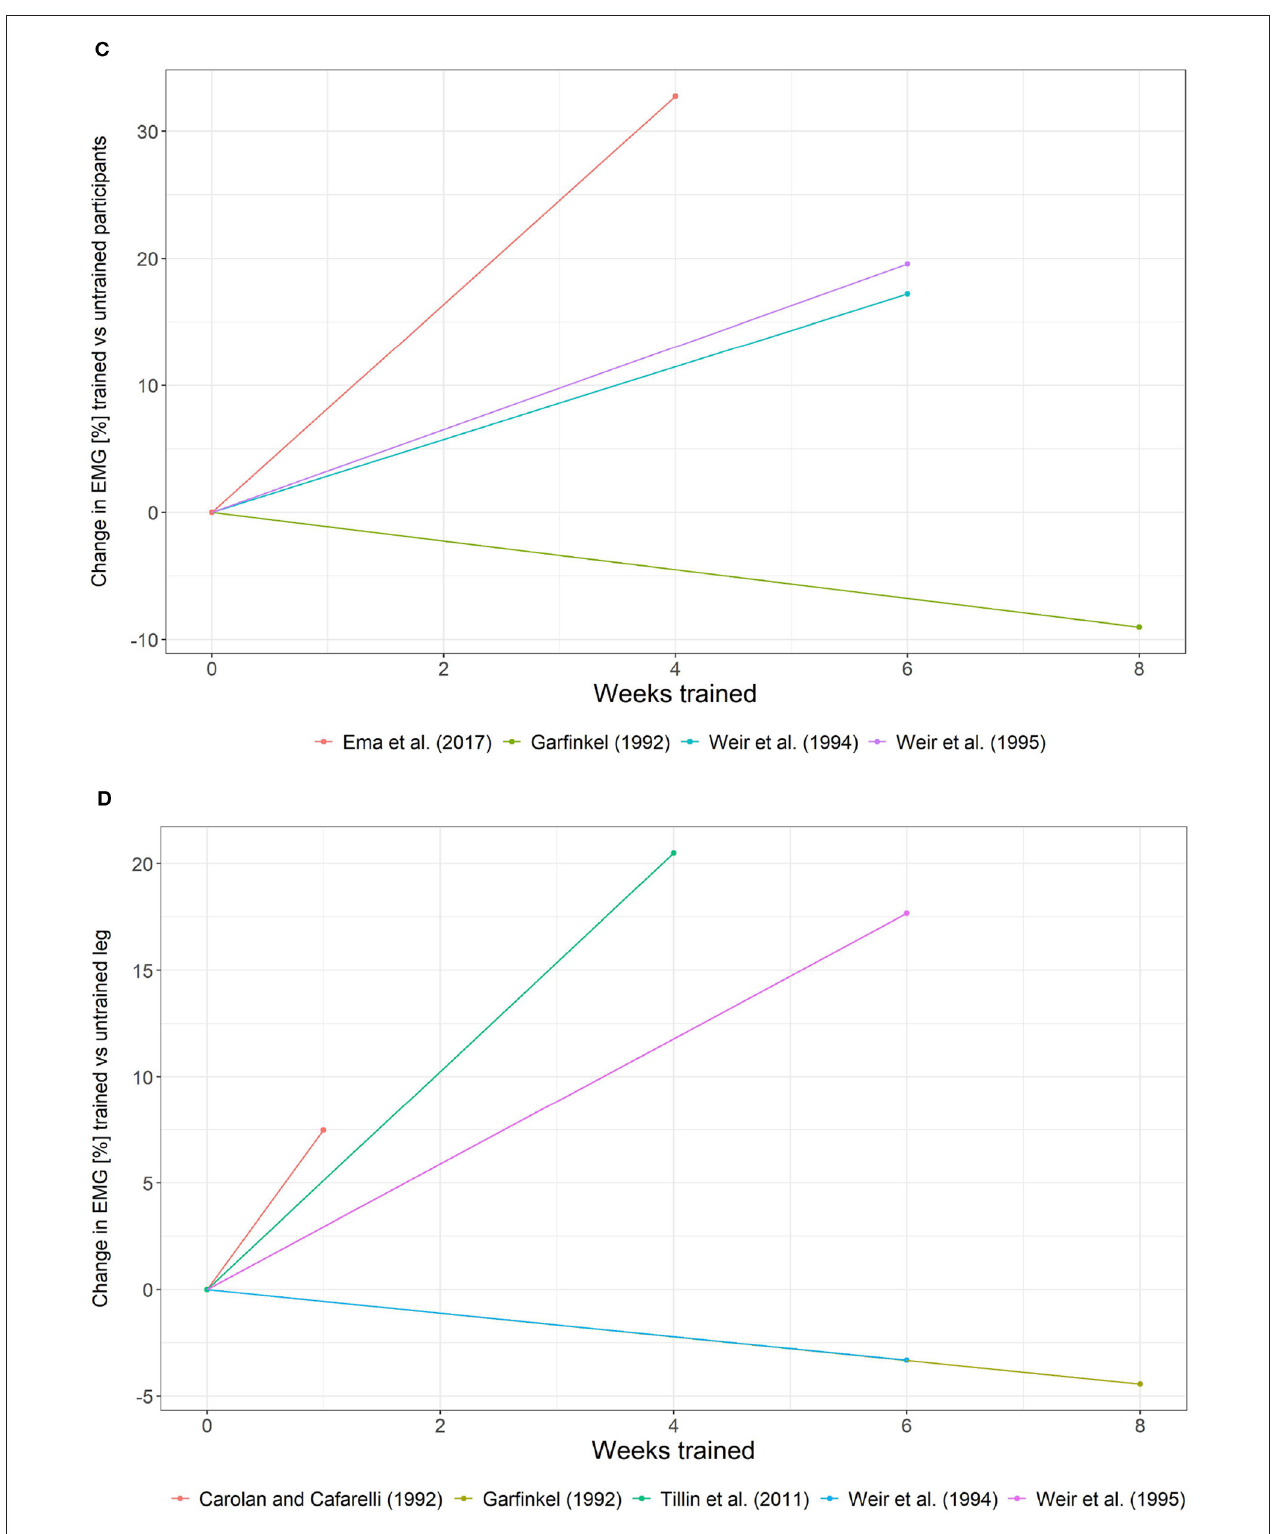
FIGURE 8 | Difference between the change in isometric strength and EMG for the control group and untrained leg data. (A) Difference between the change in isometric strength for the trained leg and the control group. (B) Difference between the change in isometric strength for the trained leg and the untrained leg. (C) Difference between the change in EMG for the trained leg and the control group. (D) Difference between the change in EMG for the trained leg and the untrained leg.